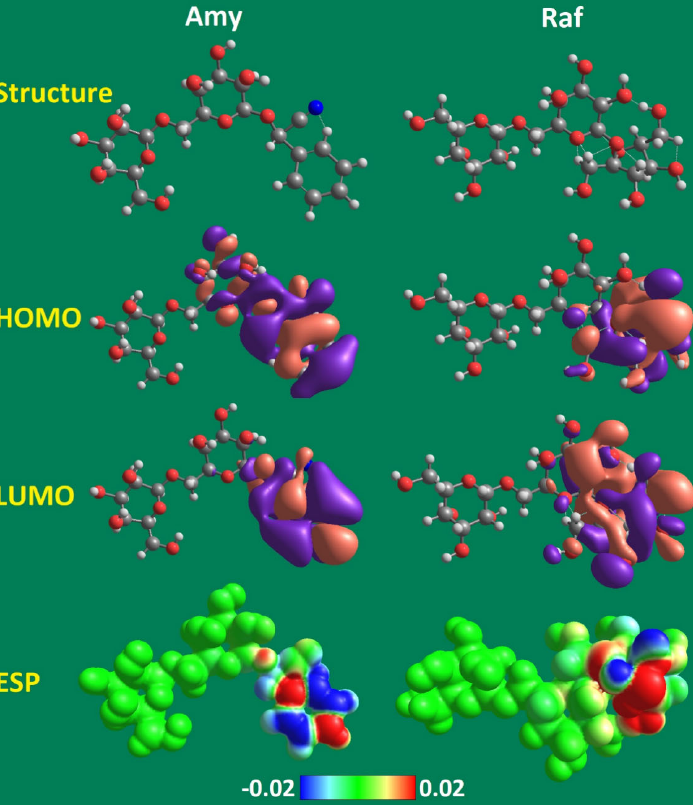
Figure 17. Optimized structure, HOMO, LUMO, and ESP maps for the studied Amy and Raf given by the B3LYP/6–31G(d,p) method. Table 10. Calculated parameters for the Amy and Raf inhibitors obtained using the DFT method at the B3LYP/6–31G(d,p) basis set.